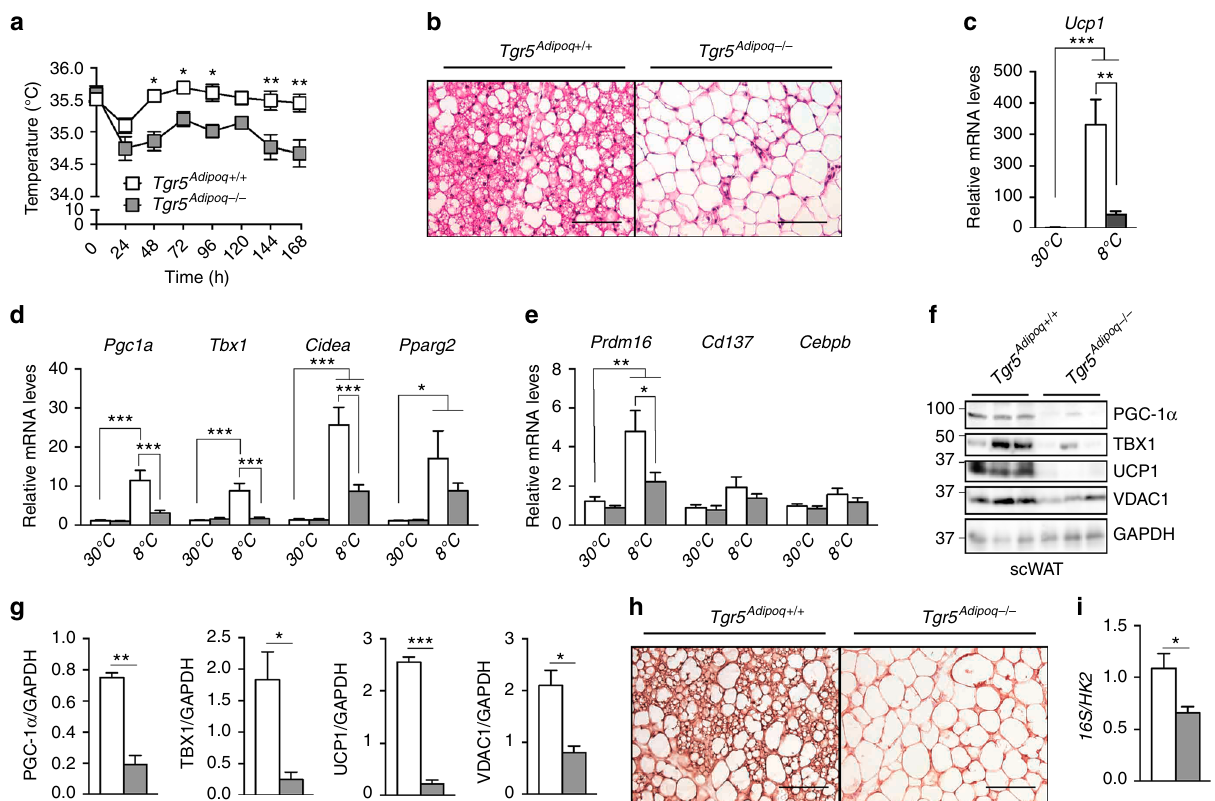
Fig. 2 Adipocyte TGR5 is required for cold-induced scWAT beiging. a Body temperature of control mice ( Tgr5 Adipoq + / + ) and WAT-speci fi c TGR5 knockout ( Tgr5 Adipoq − / − ) mice exposed to cold (8 °C) for 7 days. n = 10 per group. b Representative ( n = 5 per group) haematoxylin and eosin stainings of scWAT of mice described in a . c – e mRNA levels of beige remodelling markers Ucp1 ( c ) Pgc1a , Tbx1 , Cidea and Pparg2 ( d ), and Prdm16 , Cd137 and Cebpb ( e ) in